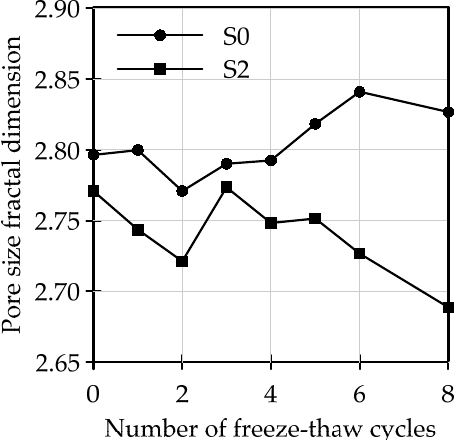
Figure 14. The curve of D hs and F-T cycles.